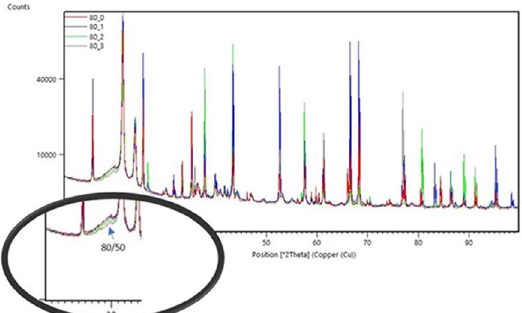
Figure 4. XRD Superimposed XRD patterns of A80/00, A80/25, A80/50, A80/75 samples.